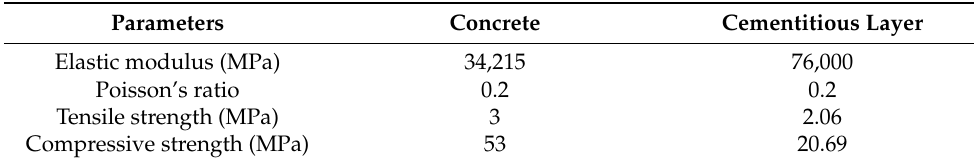
Table 1. Properties of concrete and cementitious materials [17].